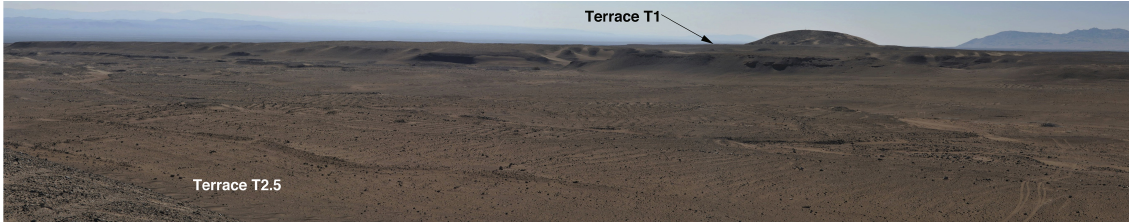
Fig. 2. A panoramic view taken looking northwest across the hyperarid Quebrada Mani (QM). Note the widespread extent of the stone-lined cultivation fields (“melgas” in spanish) on the T2.5 terrace. The valley is approximately 300m wide and the T1 (late Miocene) terrace is visible in the near background. The low hill to the centre right is Cerro Challacollo (1503ma.s.l.).